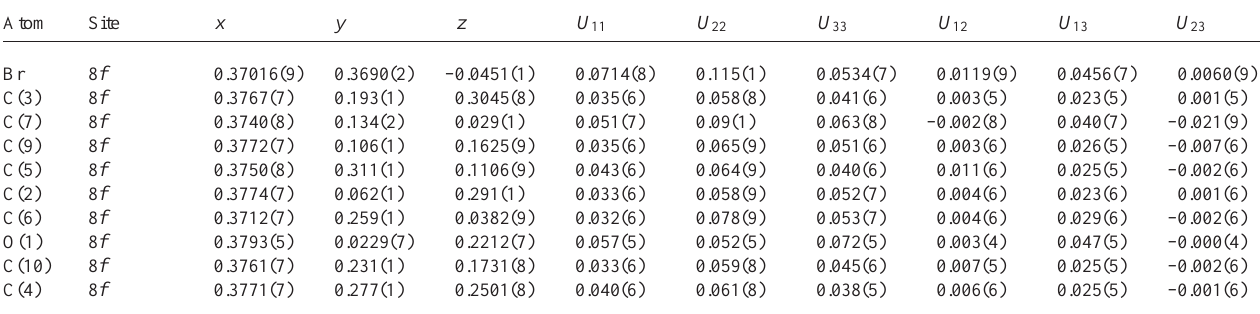
Table 3. Atomic coordinates and displacement parameters (in Å 2 ) .